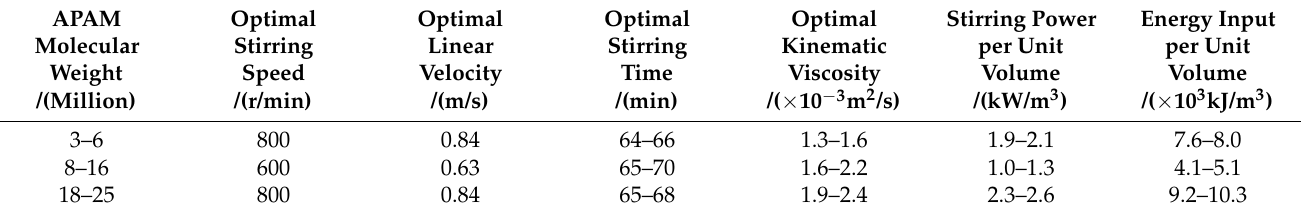
Table 2. Optimal dissolution parameters range of APAM with different molecular